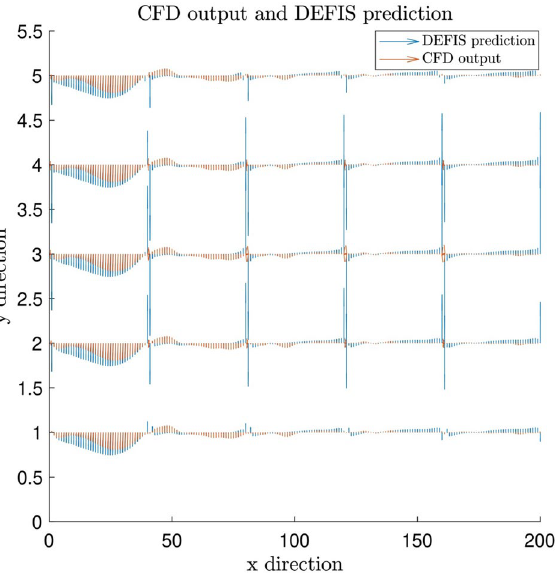
Figure 7. Comparison of gas velocity between predicted output via DEFIS and CFD output, x direction is number of data (node) and y direction is different heights.